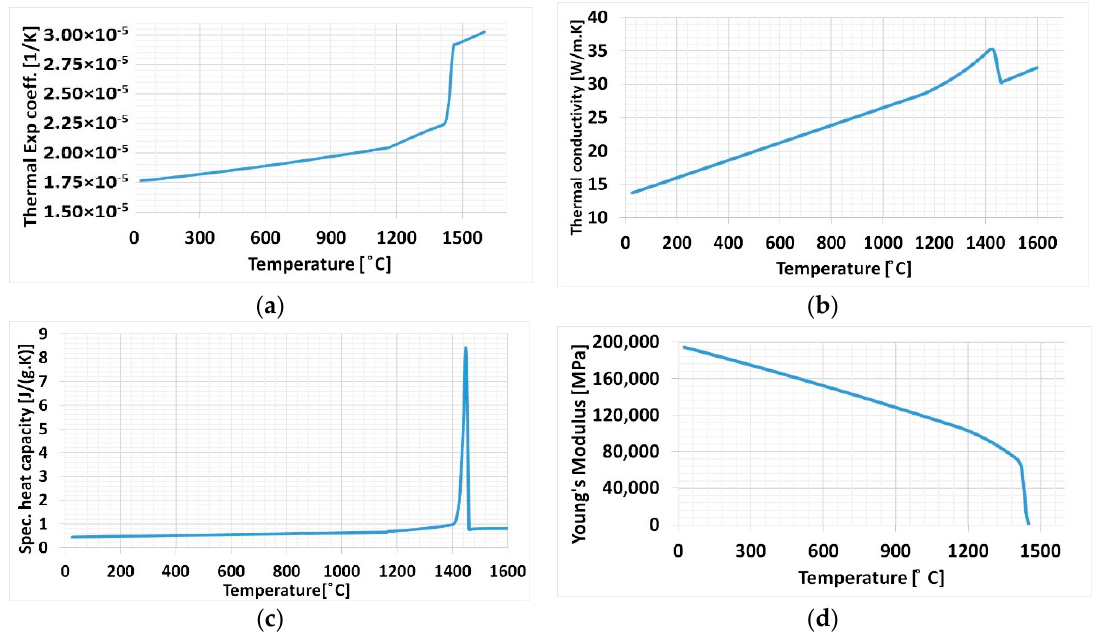
Figure 1. Temperature-dependent material properties for steel 316L ( a ) Thermal expansion coefficient; ( b ) Thermal conductivity; ( c ) Specific heat capacity; ( d ) Young’s